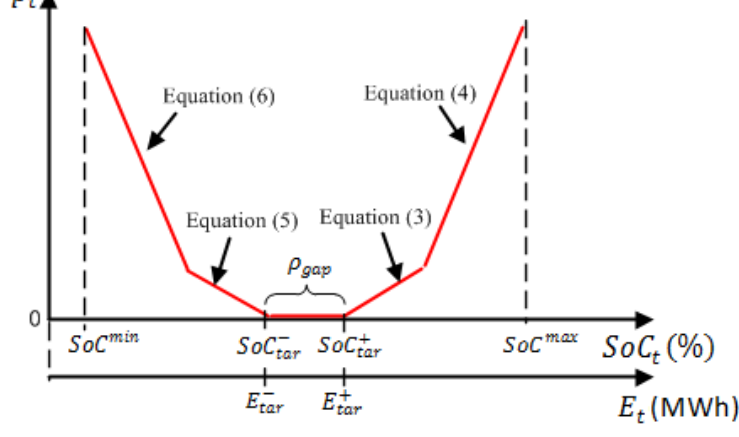
Figure 3. SoC deviation penalty function p t